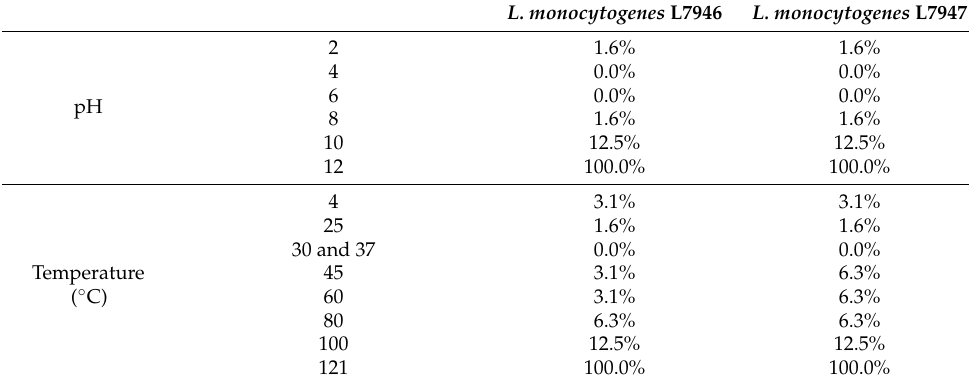
Table 1. Effect of different treatments on bacteriocin(s) activity against the target organisms L. monocytogenes L7946 and L. monocytogenes L7947, expressed in corresponding percentage values (%) of